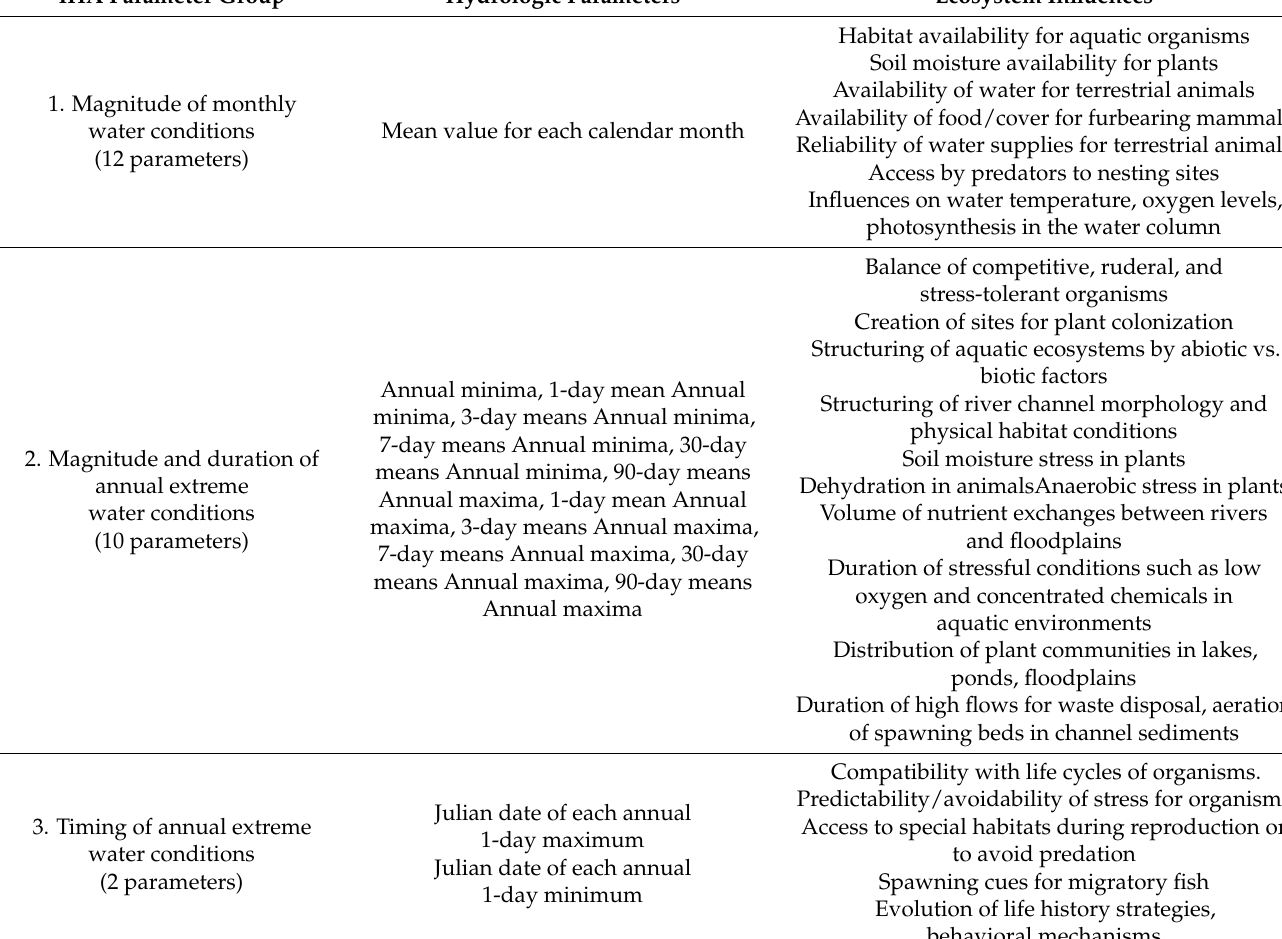
Table 5. Summary of hydrological parameters used in the IHA to characterize the flow regime and their ecosystem influences. IHA Parameter Group Hydrologic Parameters Ecosystem